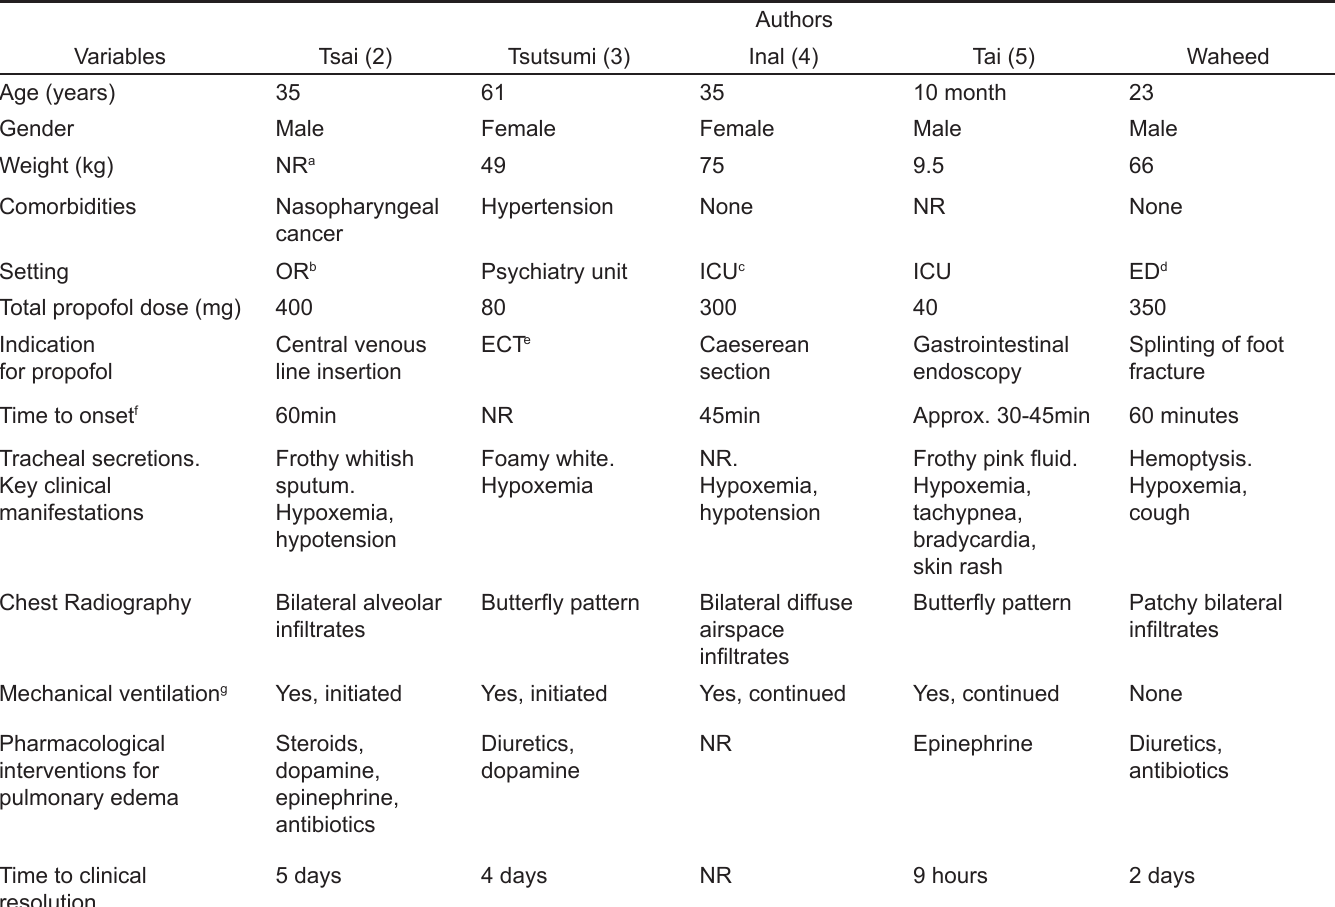
Table . Clinical characteristics of patients with propofol-associated pulmonary